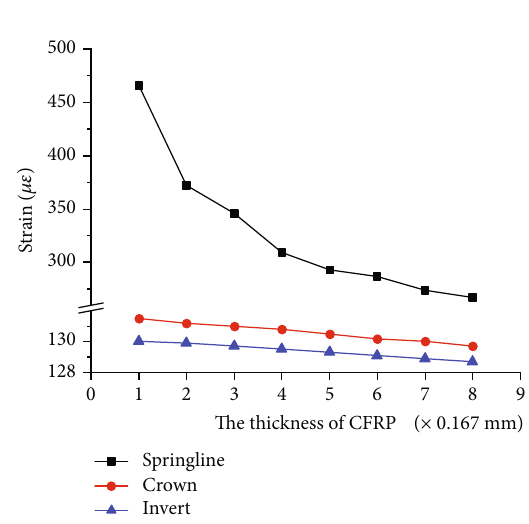
Figure 10: Strain of CFRP under combined